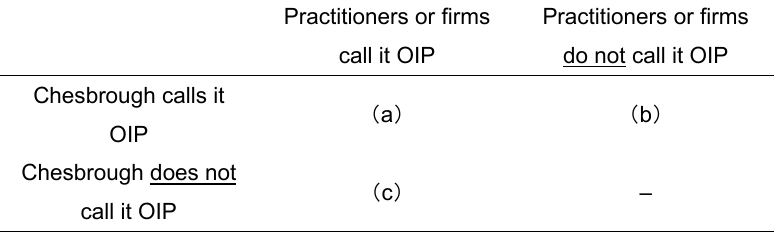
Table 3. Classification of open innovation practice (OIP) (1) Practitioners or